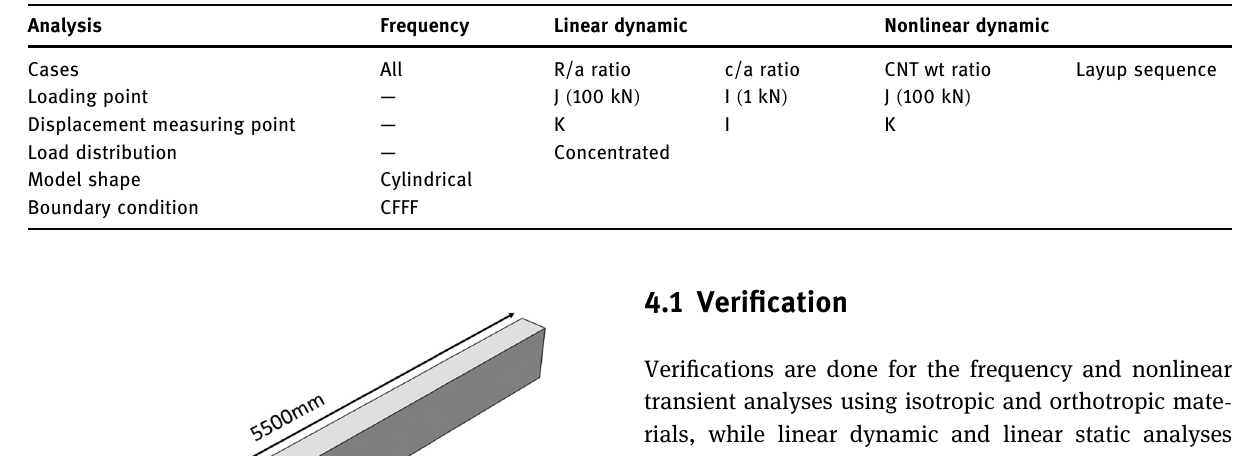
Table 1: Details used for the three di ff erent analyses of CNTFPC panel